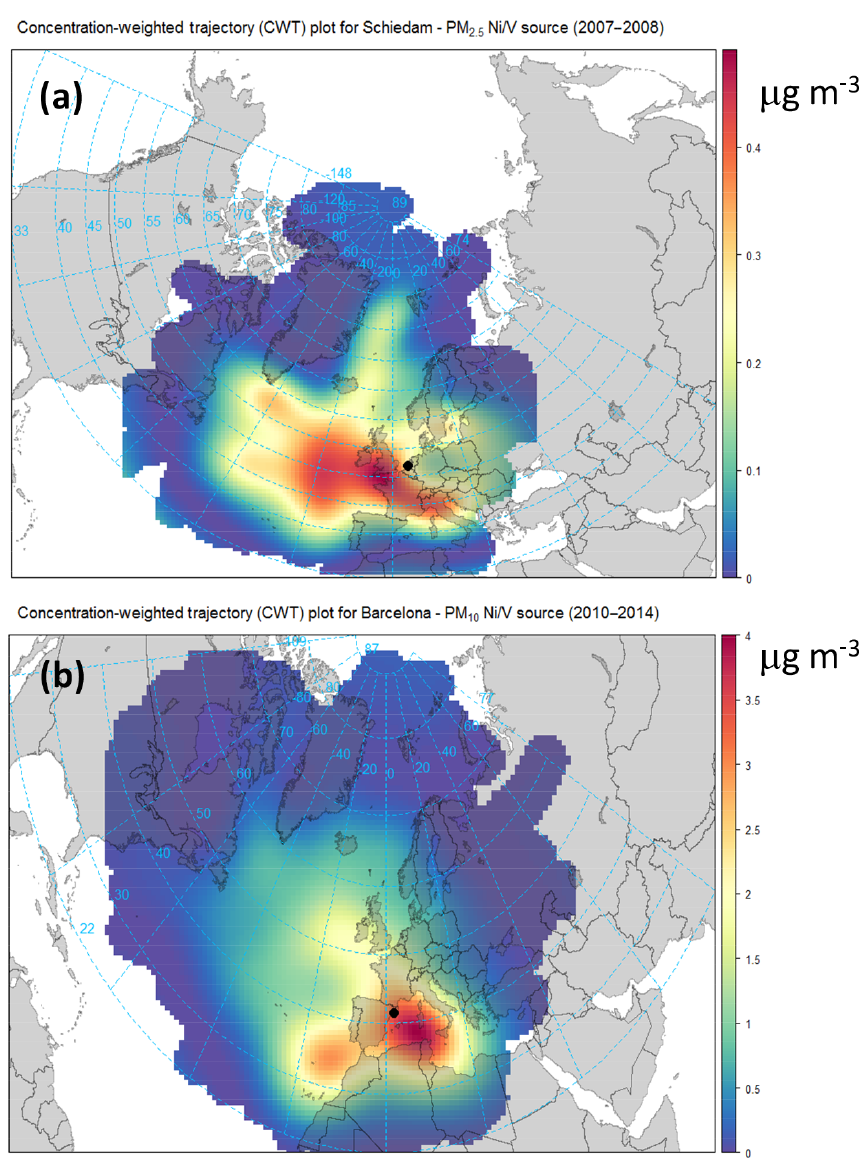
Figure 3. Concentration-weighted trajectory (CWT) plots of the V–Ni source contributions for (a) Schiedam (NL; PM 2 . 5 ; 2007–2008) and (b) Barcelona (ES; PM 10 ;